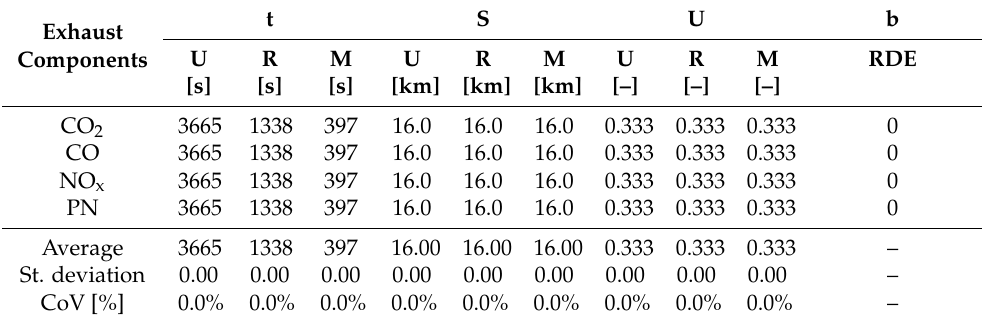
Table A5. Road emissions for the RDE test (assuming variable exhaust emission intensity)—output data obtained from the algorithm and the proposed values for the generalized test (Vehicle A).